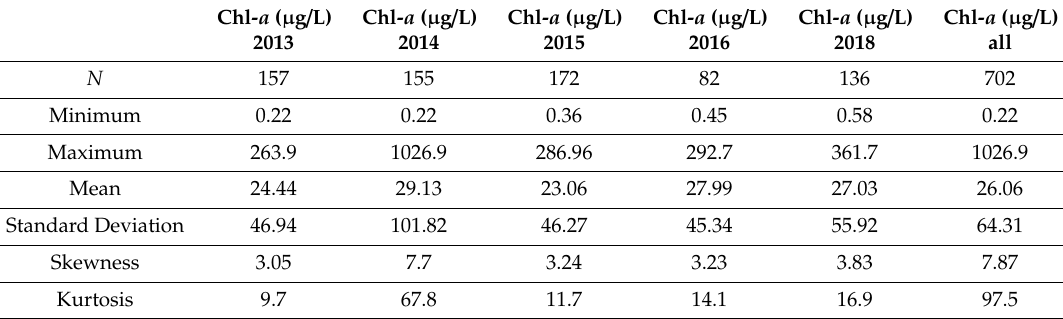
Table 4. Descriptive statistics summary table of in situ chlorophyll- a (Chl- a ) of years 2013–2016 and